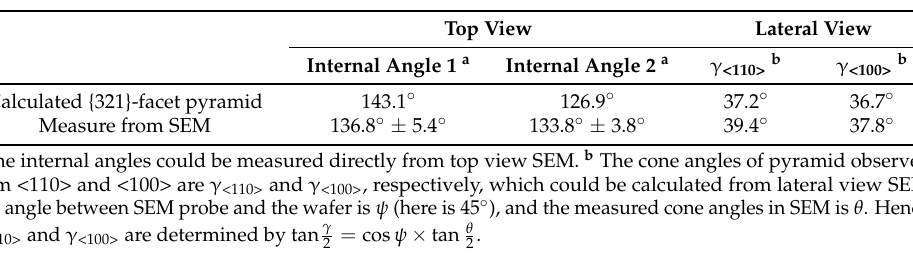
Figure 6. SEMs of Microneedle arrays with ( a ) 270 μ m height and 420 μ m pitch; ( b ) 900 μ m height and 340 μ m pitch.